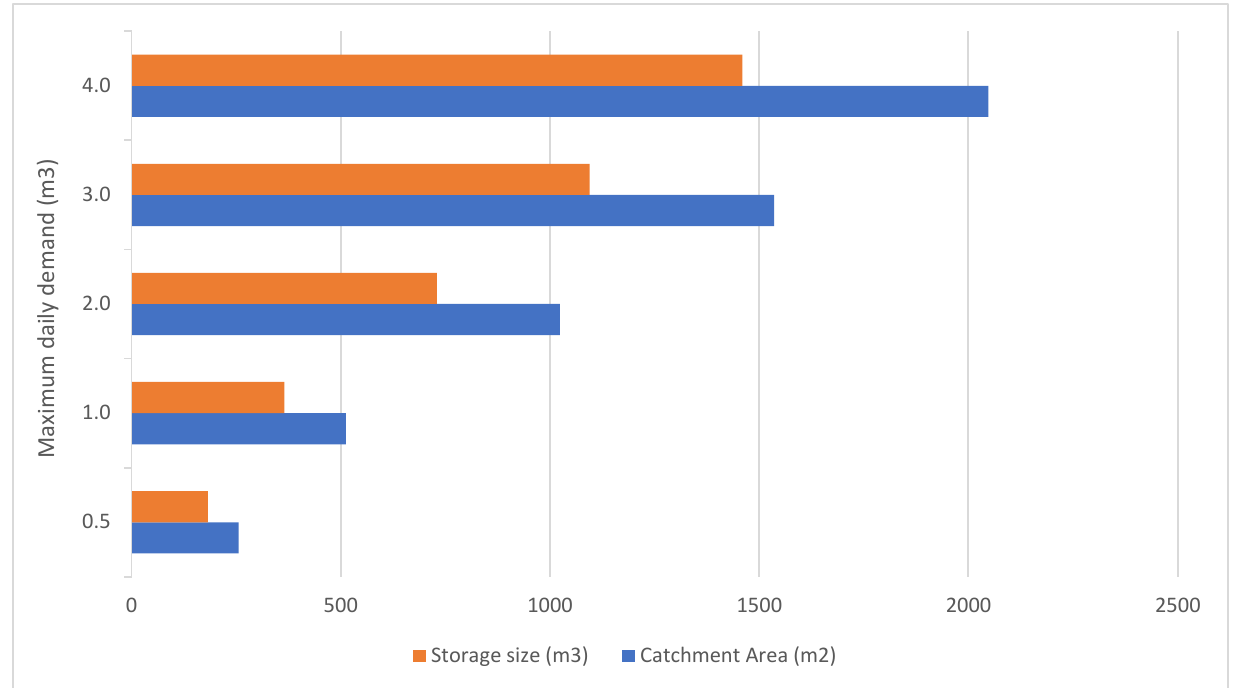
Figure 10. Illustration of water demand and resulting maximum catchment (m 2 ) and storage (m 3 ) sizes for securing the demand from unpaved surfaces.